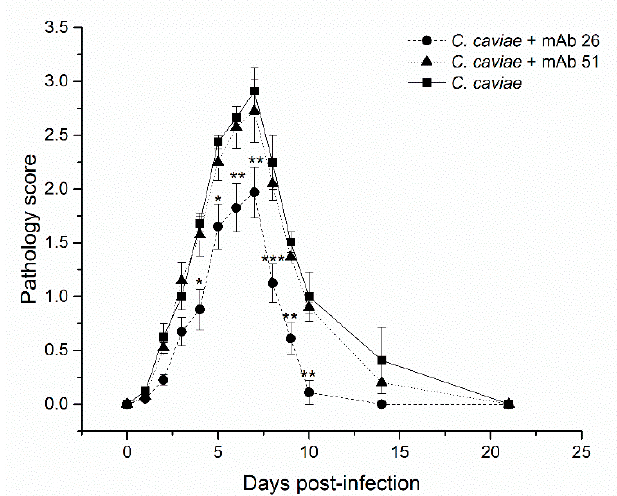
Figure 5. The impact of mAb26 and mAb51 on in vivo ocular chlamydial infection in guinea pigs. Guinea pigs ( n = 5 per group) were infected (day 0) by 1 × 10 4 infectious forming units (IFU) of C. caviae (preincubated without / with either mAb26 or mAb51 (10 µ g / mL, 1 h / RT). Upon the infection, the local treatment with the corresponding mAb (10 µ g / mL, 25 µ L / eye) was performed daily until day 7 post-infection. Guinea pigs were monitored until the resolution of infection (day 21). The results represent the mean of pathology score ± S.E: * p < 0.05, ** p < 0.01, *** p < 0.001.